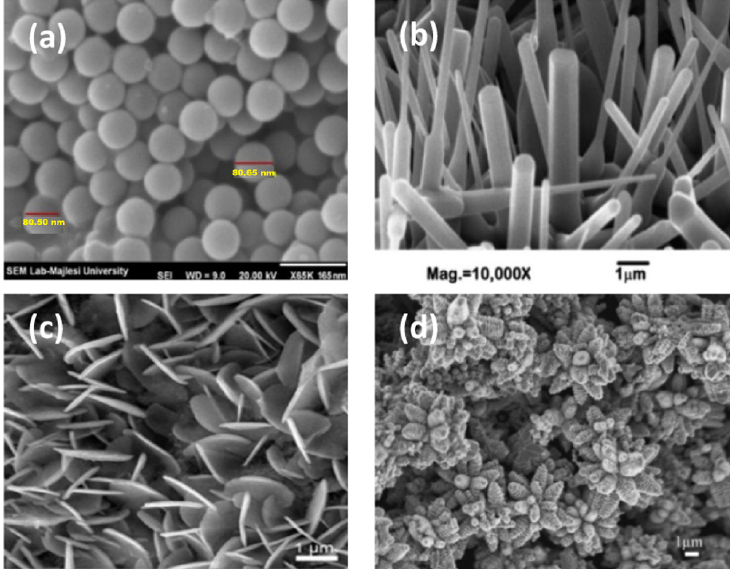
Figure 2. Structures shared by ZnO: ( a ) rock salt, B1; ( b ) zinc blende, B3; and ( c ) wurtzite, B4 ( d ) tetrahedral ZnO. The shaded grey and black balls represent O and Zn atoms, respectively [114].